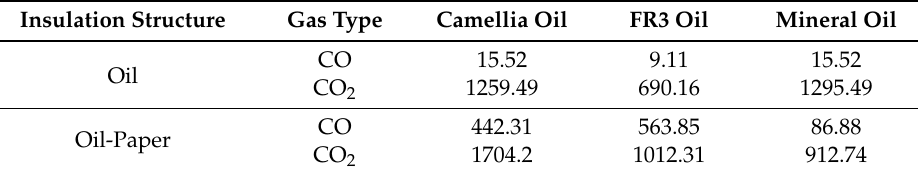
Table 6. CO and CO 2 content (in ppm) in oil under needle-disc breakdown.